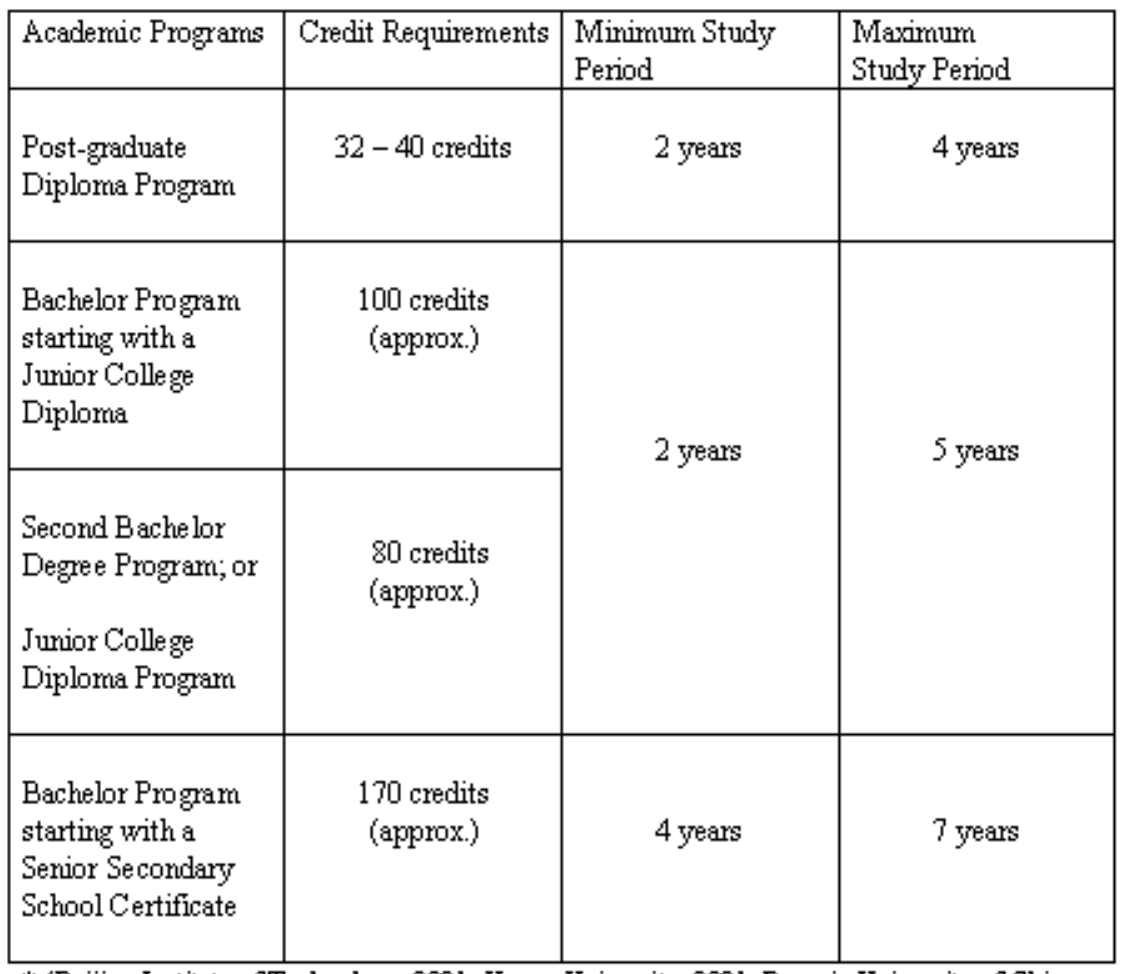
Table 5: Credit System and Periods of Study for Web-based